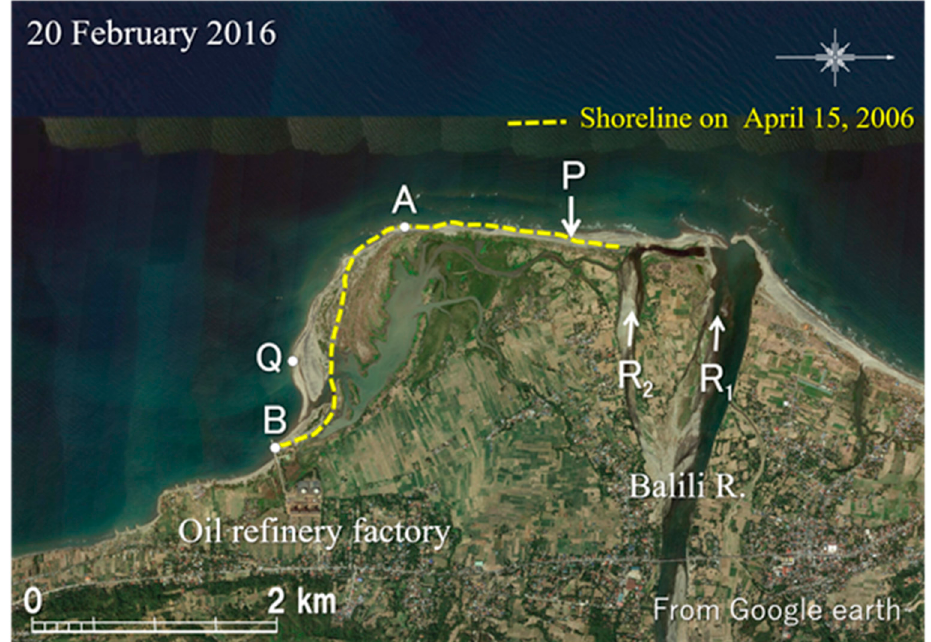
Figure 6. Satellite image of shoreline around Balili River mouth (20 February 2016). A similar change continued until 1 December 2016, leaving an opening of the lagoon at the east end of the sandbar (Figure 7). In this year, a river delta was formed again around the mouth of R 1 owing to sediment discharge from the river, indicating the occurrence of the intermittent sand supply from the Balili River.